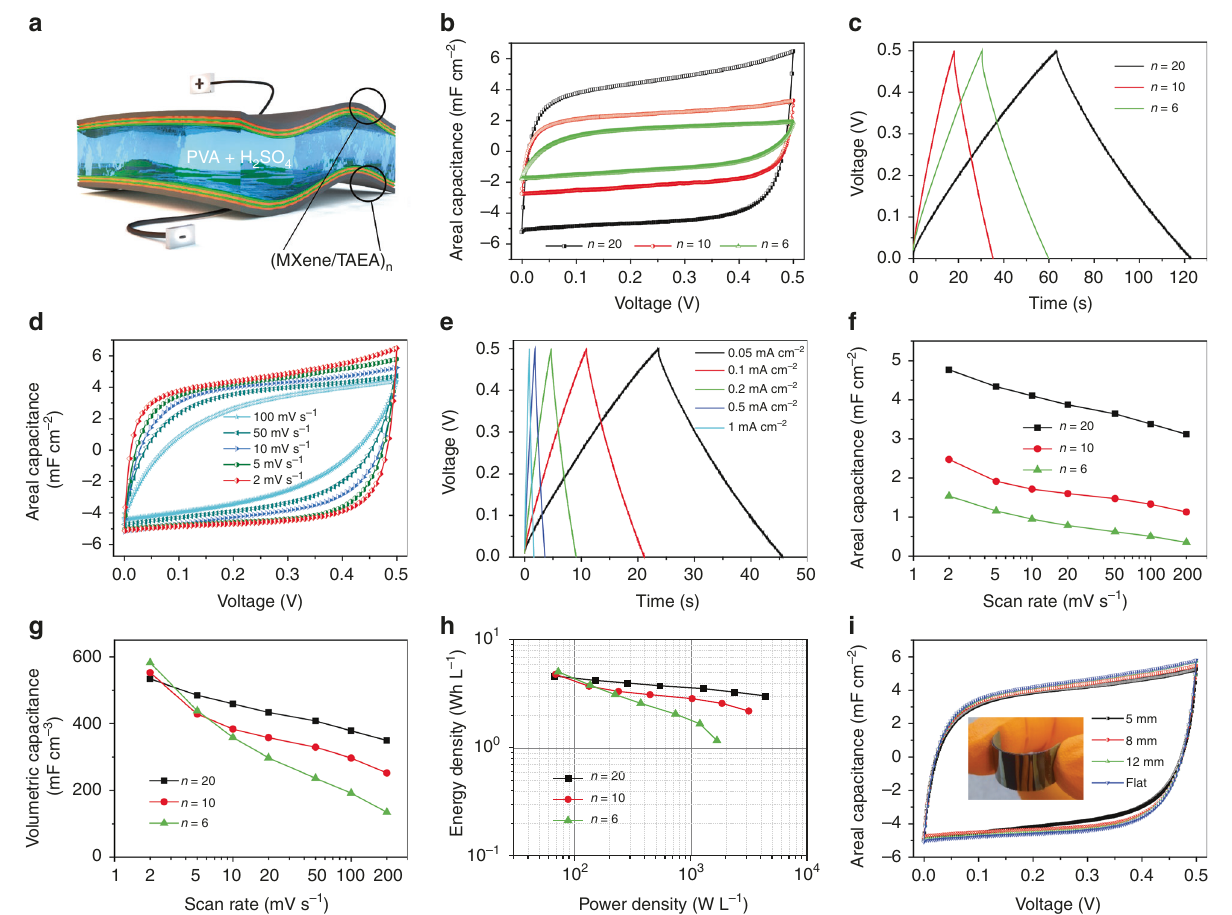
Fig. 5 Electrochemical performance of fl exible solid-state supercapacitors based on (MXene/TAEA) n electrodes. a Schematic illustration of a solid-state supercapacitor based on (MXene/TAEA) n on PET sheet as electrodes and PVA/H 2 SO 4 as the electrolyte. b CV curves at a scan rate of 2 mV s − 1 , and c charge-discharge pro fi les at a current density of 0.02 mA cm − 2 for (MXene/TAEA) n with bilayer number n. d CV curves at different scan rates and e charge-discharge pro fi les at different current densities of (MXene/TAEA) 20 . f Areal capacitances, and g volumetric capacitances of (MXene/TAEA) n with different bilayer numbers, n, at different scan rates. h Ragone plot of (MXene/TAEA) n solid-state supercapacitors based on total active electrode volume. i CV curves of (MXene/TAEA) 20 solid-state supercapacitors measured for different degrees of bending, and the inset shows a photograph of